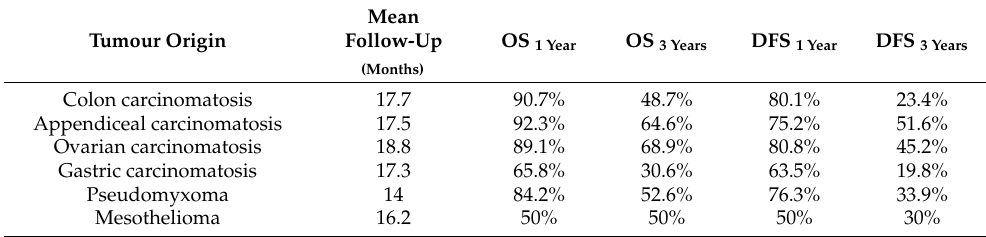
Table 6. OS and DFS, by tumour histology, 1 and 3 years after HIPEC